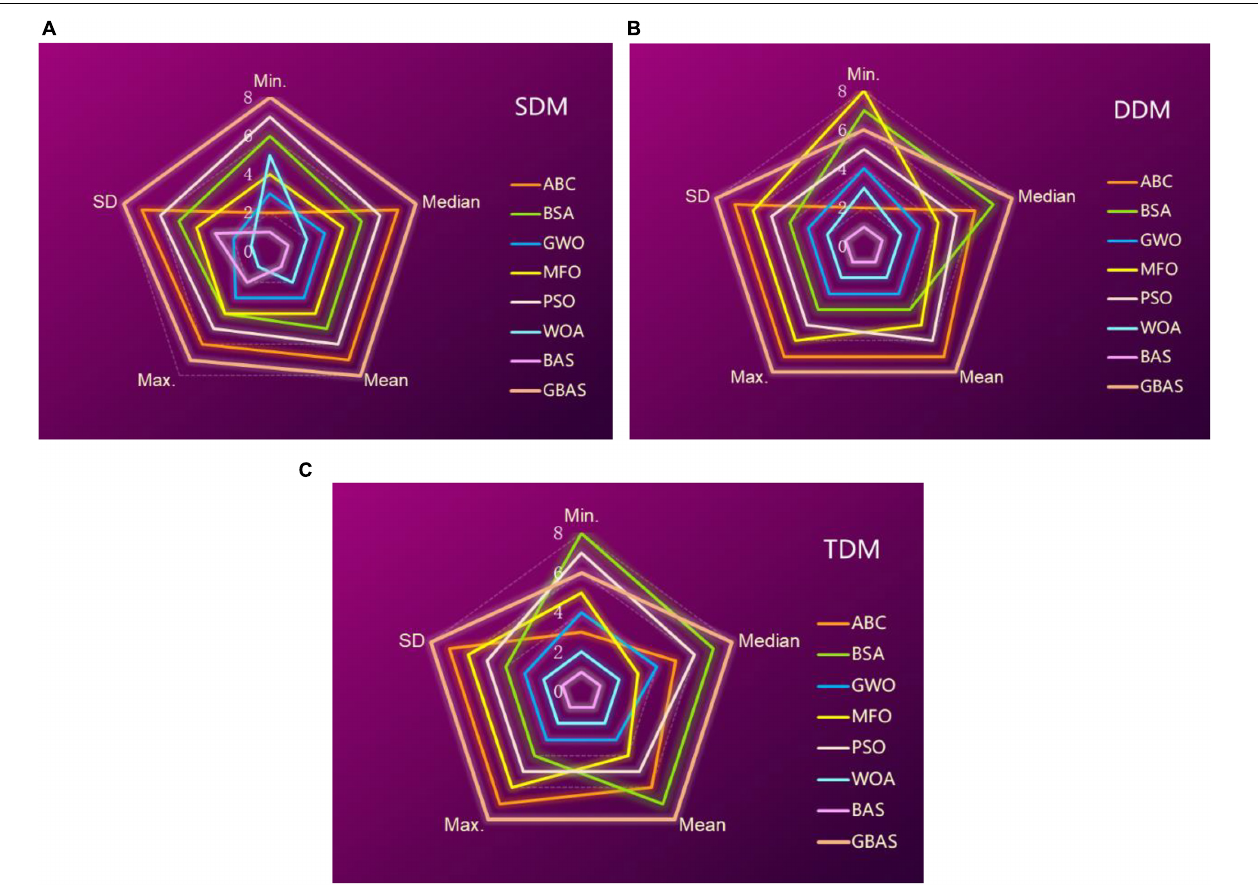
FIGURE 5 | Radar graphs of various algorithms: (A) single diode model (SDM), (B) double diode model (DDM), and (C) triple diode model